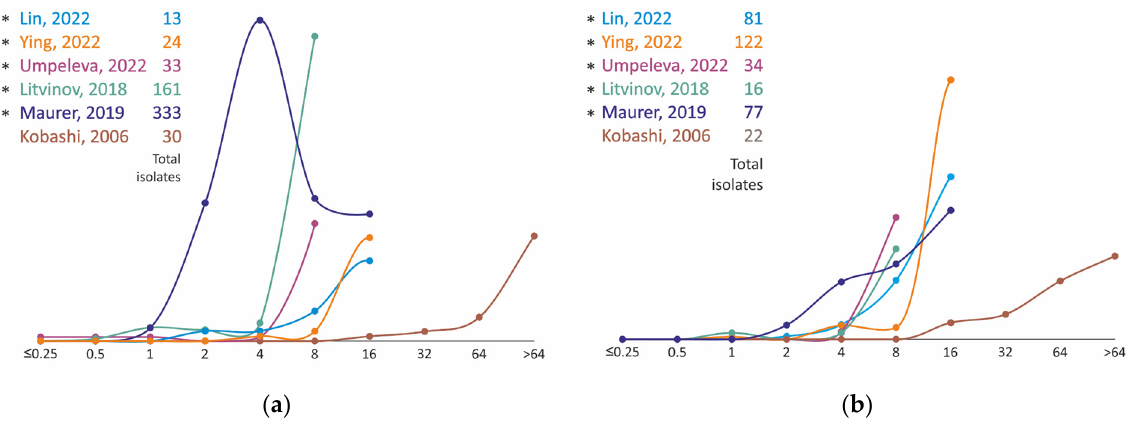
Figure 6. Isoniazid MIC distribution for clinical isolates of M. avium ( a ) and M. intracellulare ( b ). *—MIC obtained using Sensititre SLOMYCO plates.